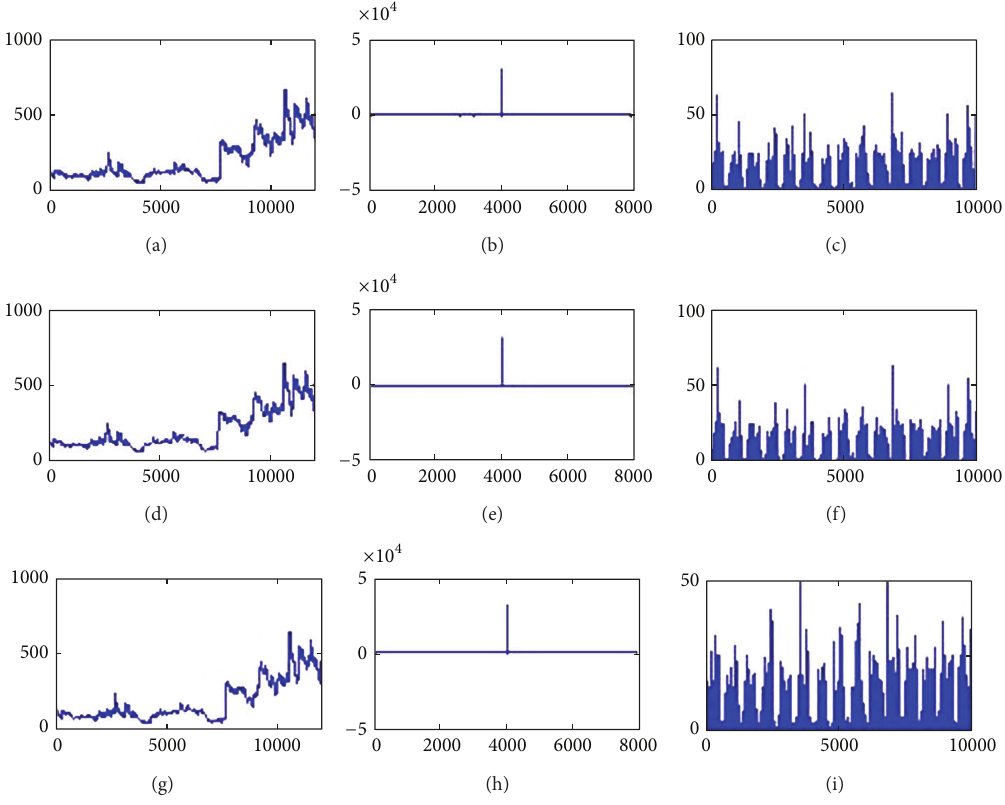
Figure 5: Time-series streams with their segmenting results: (a) IBM stock price, (b) ICU, and (c) Dodger. (d)–(f) Segmenting result with bottom-up. (g)–(i) Segmenting result with PRESEE.